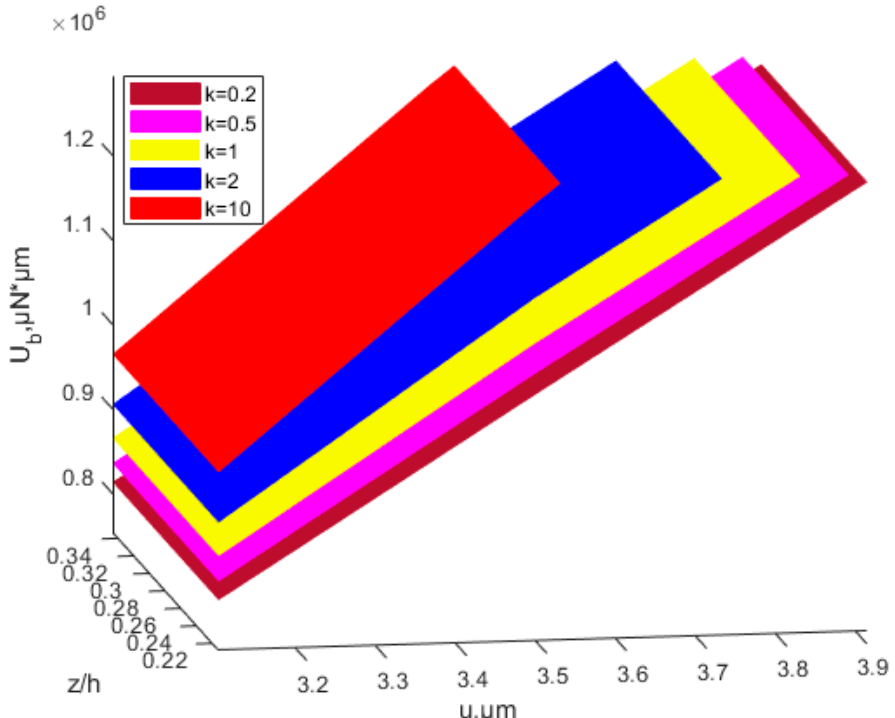
Figure 14. Influence of the power-law distribution of the scale effect on buckling strain energy of the FGM plate.